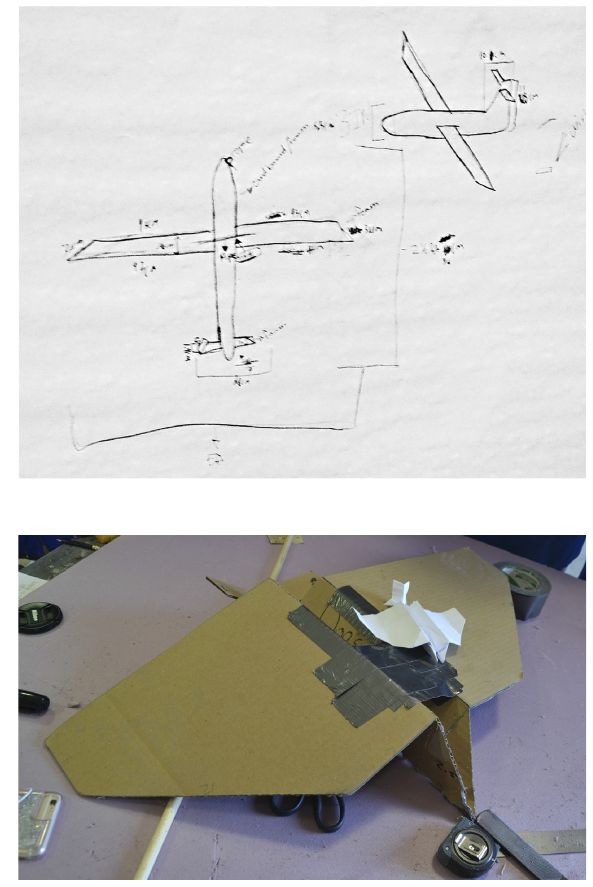
Figure 2. One middle school group ’ s prototype for a glider